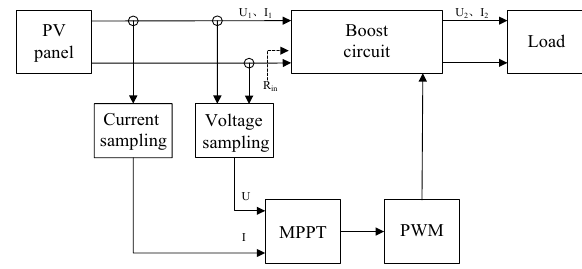
Figure 1. Composition of photovoltaic power generation